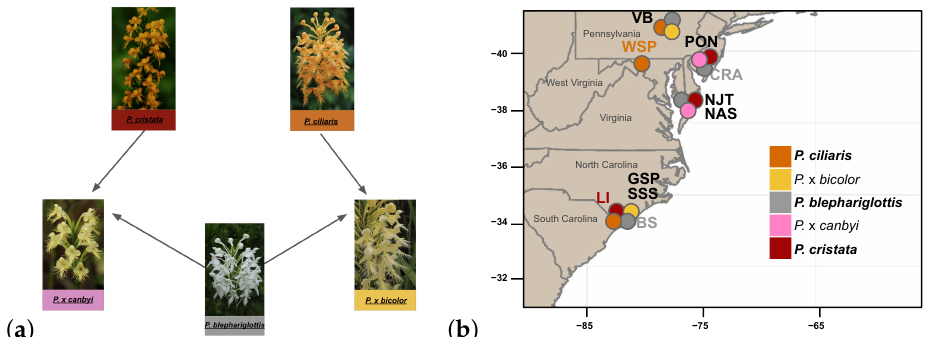
Figure 1. ( a ) Platanthera hybrid complex. The parent species P. blephariglottis (gray) crosses with P. cristata (red) to form P. x canbyi (pink) and with P. ciliaris (orange) to form P. x bicolor (yellow). ( b ) Site acronyms represent the approximate locations of ten sites across the Eastern United